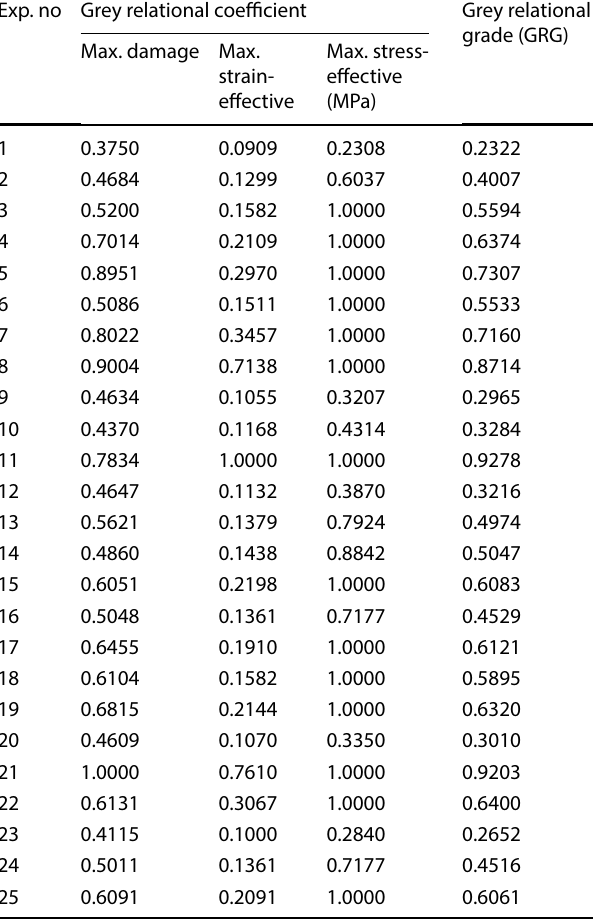
Table 6 Table of grey relational coefficient values and their respec- tive grey grade Exp. no Grey relational